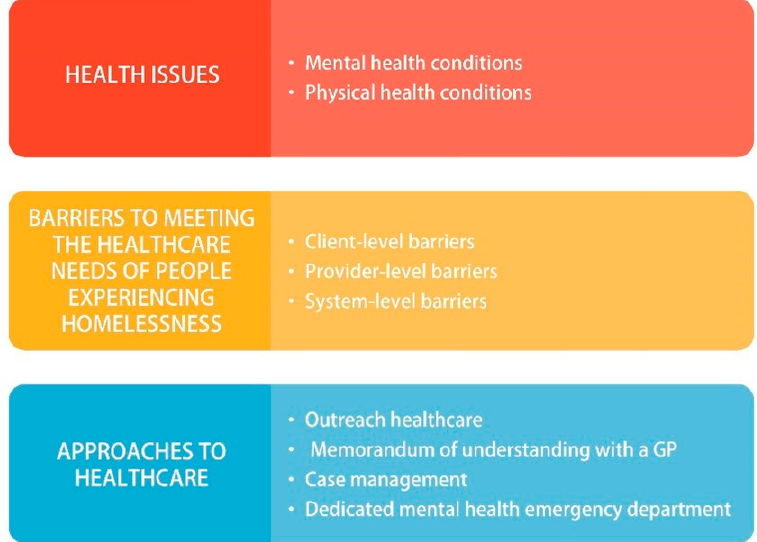
Figure 1. Themes and sub-themes.